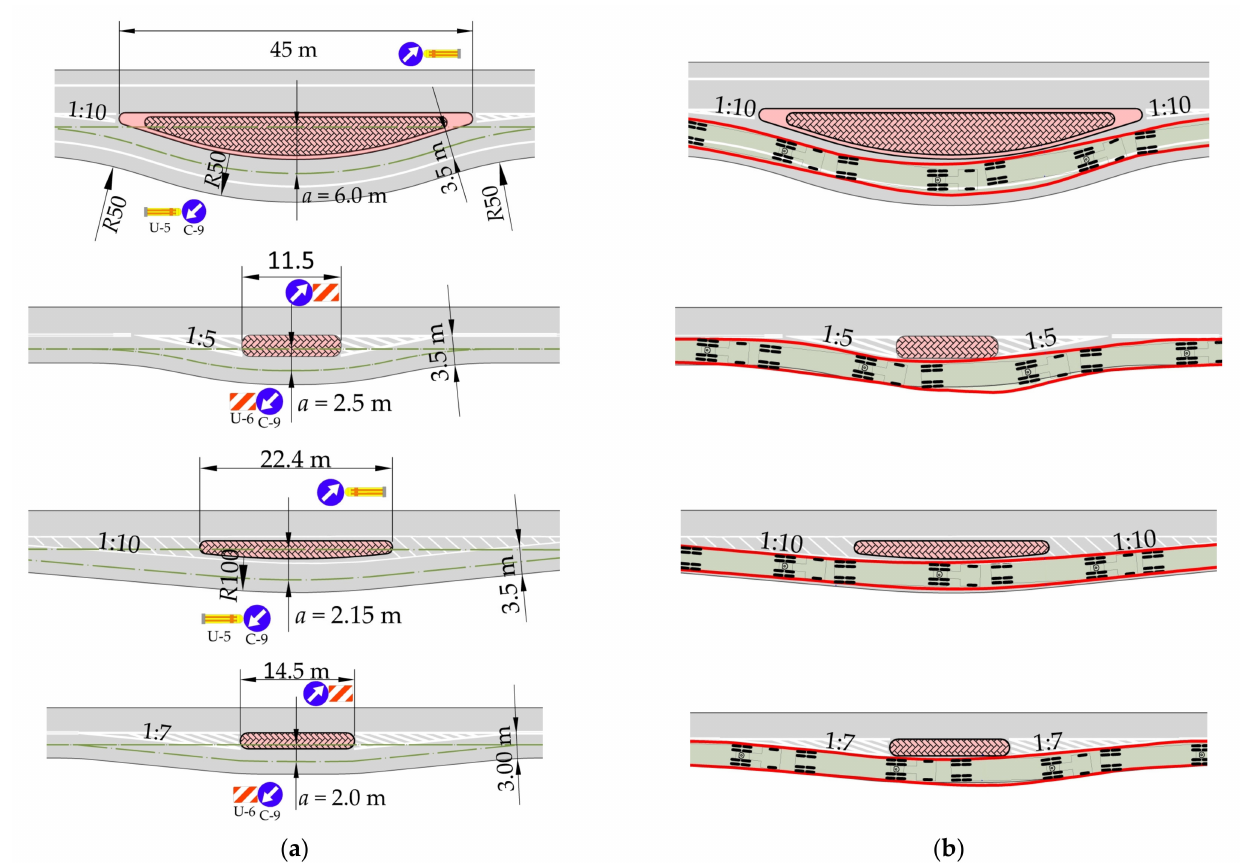
Figure 2. The shape and the main dimensions of chicanes affecting one lane only, installed on the analysed test sections imposing deflections of 6 m, 2.5 m, 2.15 m and 2 m: ( a ) basic layout and traffic control signs used; ( b ) HGV driving envelope and